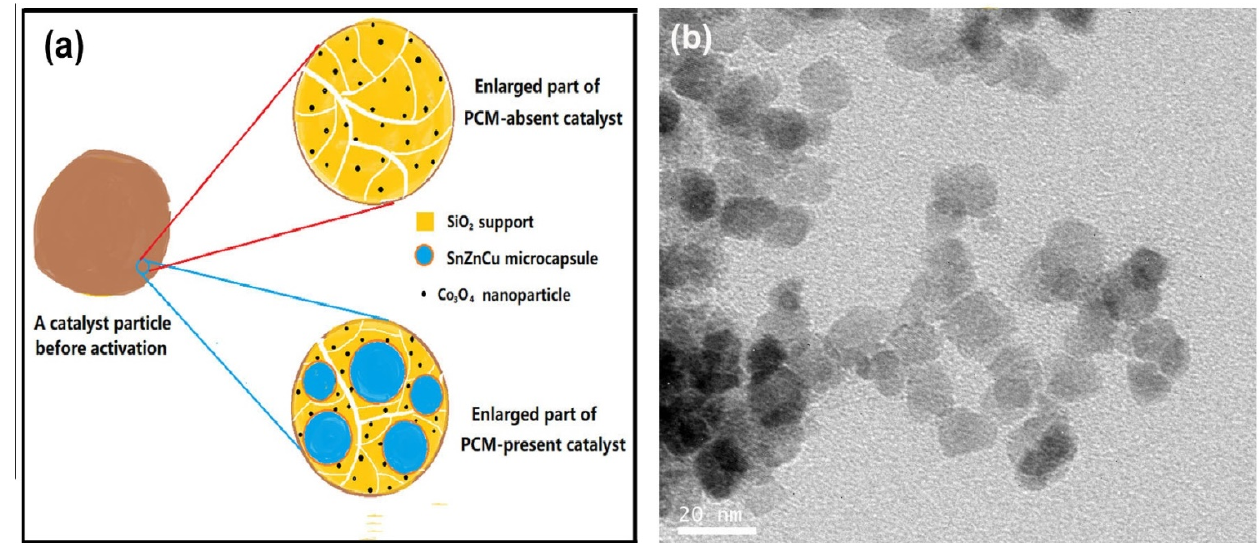
Figure 12. ( a ) Illustration for the structural difference between PCM-absent and PCM-present Co/SiO 2 catalysts before activation and ( b ) TEM image of Co 3 O 4 nanoparticles.